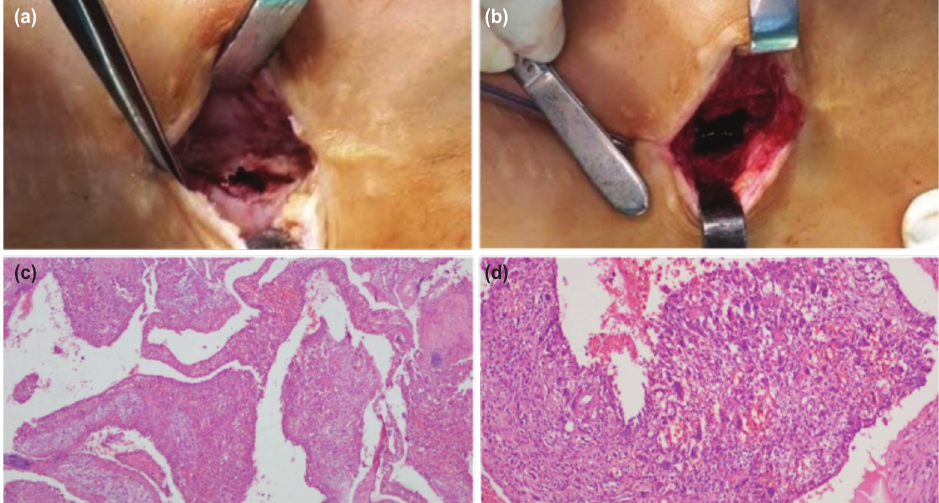
(a) Intra-operative image of the cystic lesion before curettage with visible cortical destruction of the lateral femoral cortex. Fig. 3: (b) Image of the cyst after curettage. (c) Histopathologic view at x40 and (d) x100 magnification with hematoxylin-eosin staining showing large irregular cystic spaces, osteoclast-like multinucleated giant cells and bone tissue.